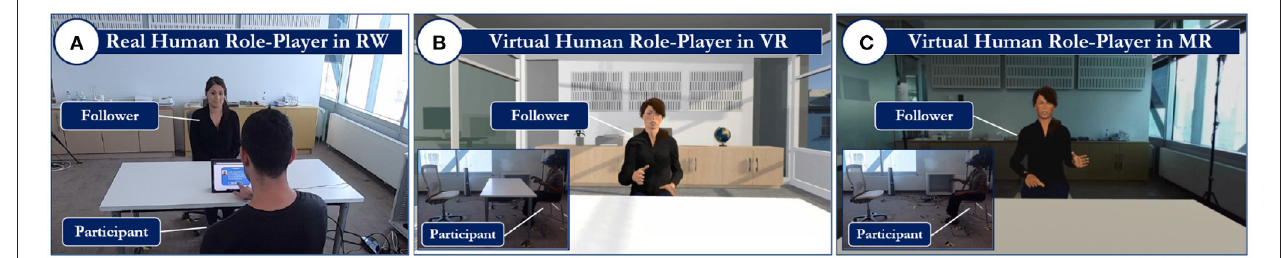
FIGURE 1 | The three conditions of our experimental leadership training platform. In a user study, we evaluated the effectiveness of Virtual Human Role-Players to support the practice of leadership skills within two computer-generated environments: (B) Virtual Reality and (C) Mixed Reality, in comparison to a traditional gold-standard method: (A) Real Human